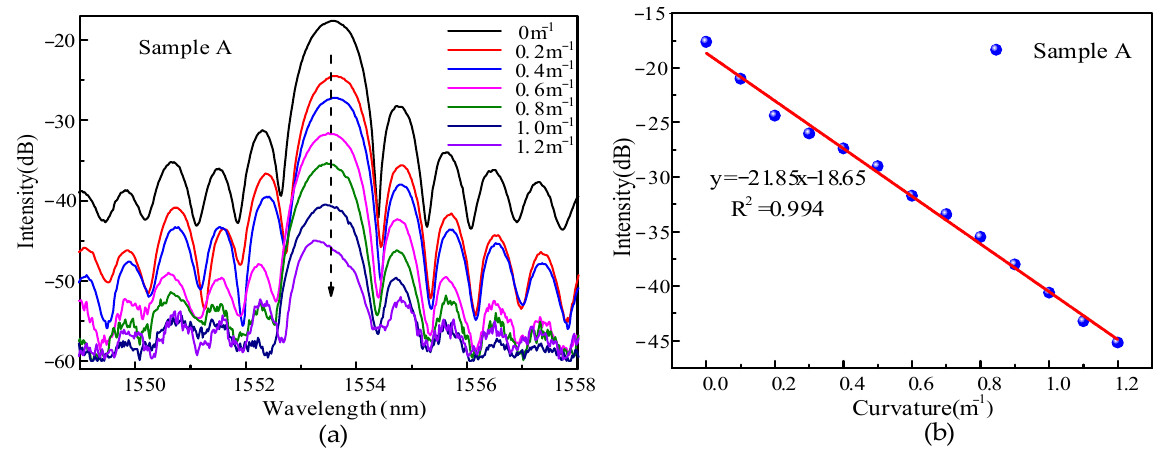
Figure 5. ( a ) Reflection spectrum of sensor under different curvature; ( b ) Bending fitting curve. The stability of the sensor was checked for ten hours when the curvature was 0.4 m −